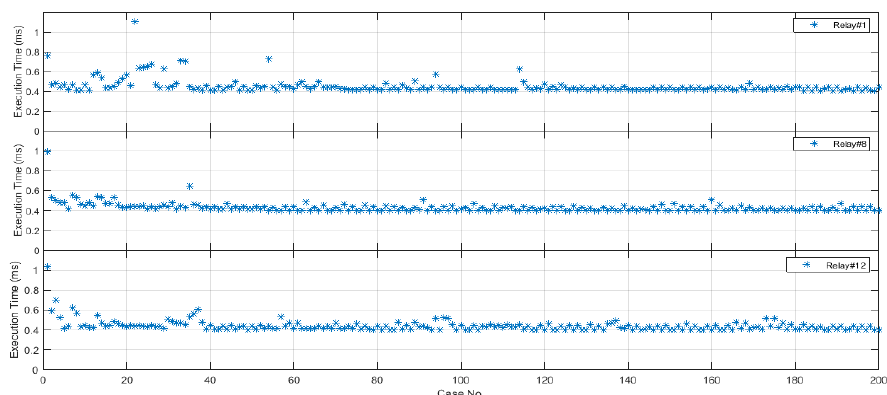
Figure 5. Execution times for Relay#1, Relay#8, and Relay#12.